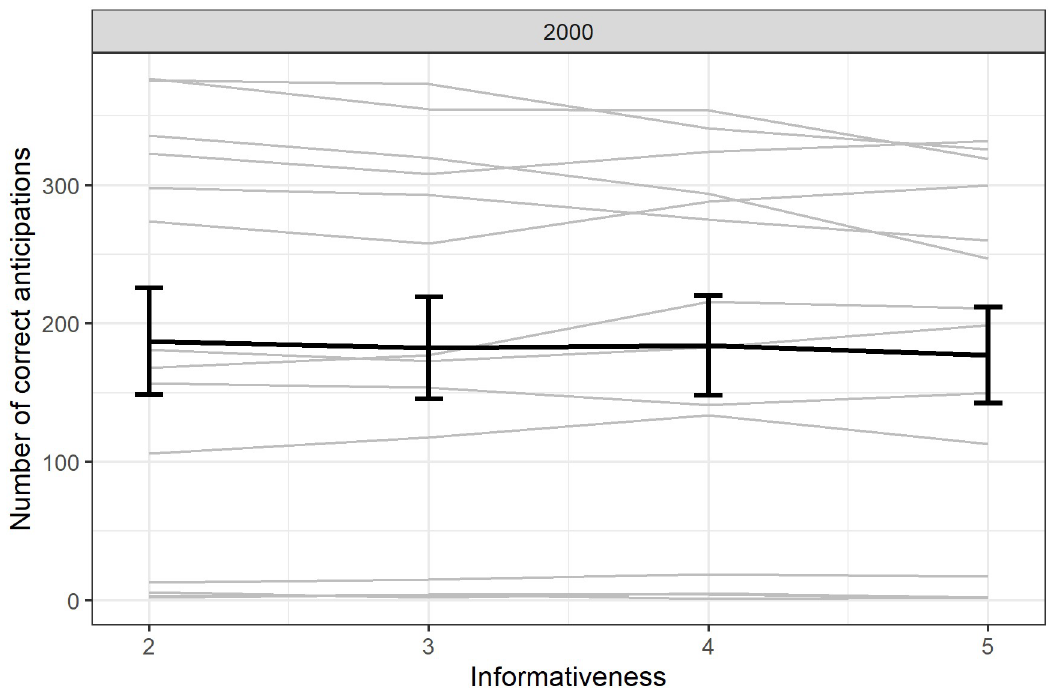
Fig 9. Effect of informativeness on the number of anticipations. Individual responses (light grey) with group average (error bars represent standard errors). In this experiment there was only one delay of 2000ms.